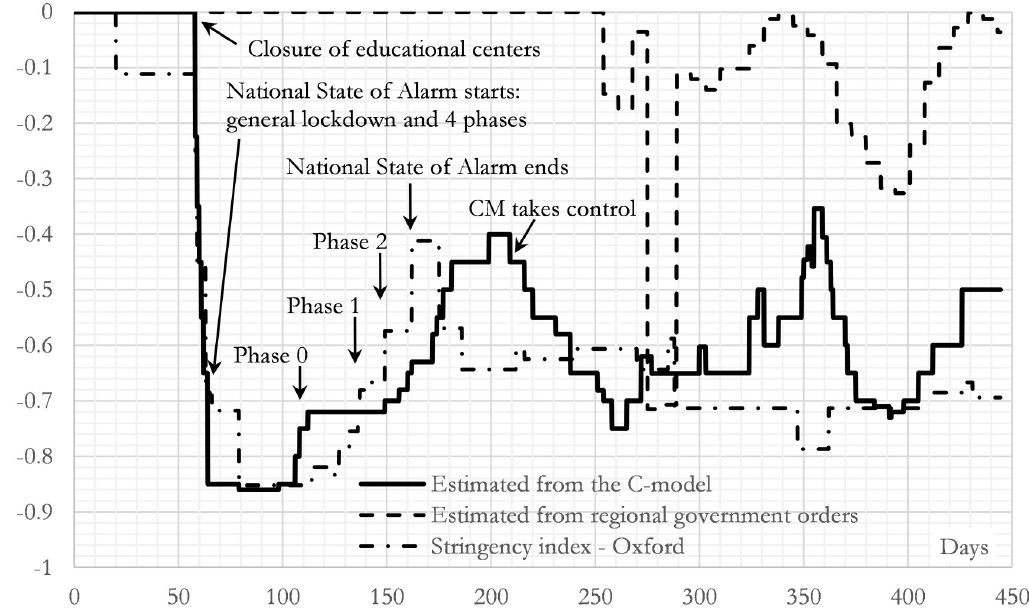
Fig 9. Estimation of the mobility parameter (Stringency index) during the studied period in the region of Madrid (CM). The solid line is the curve obtained by fitting the C-model: it ensures that the C-model generates the official time series shown in Fig 3. The lower dash line shows the estimation of the Stringency Index of Spain made by [47] taking into account the national restrictions. The upper dash line shows an estimation of the CM’s population affected by the local government restrictions (without taking into account the national